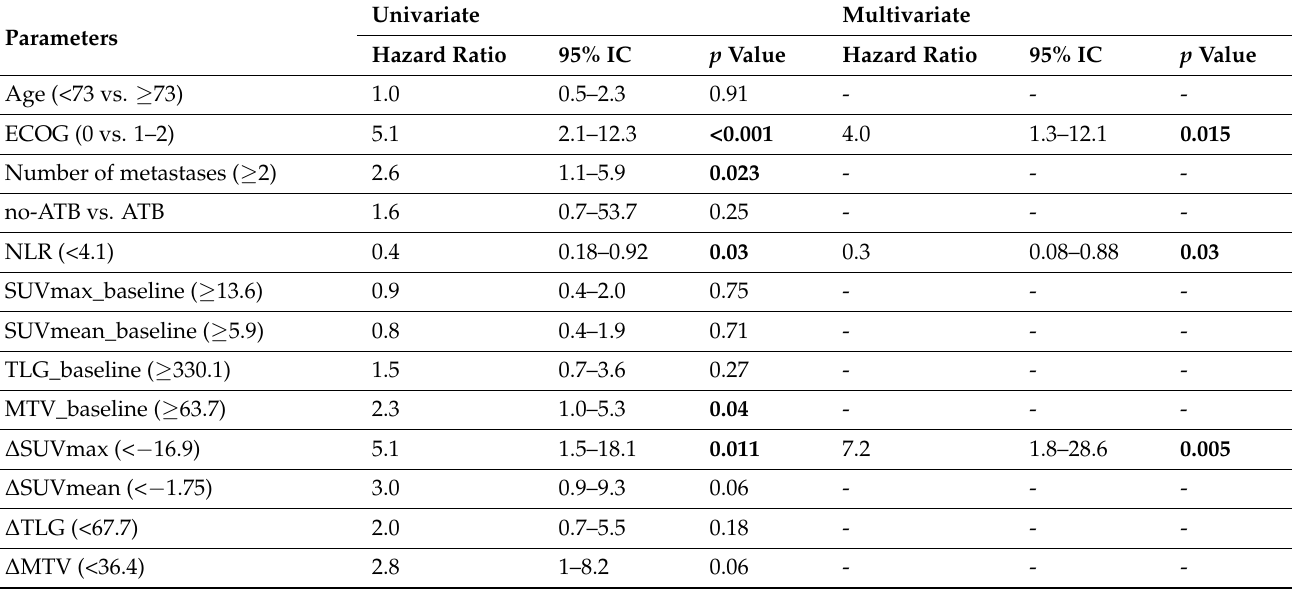
Table 4. Uni- and multivariate analysis for overall survival